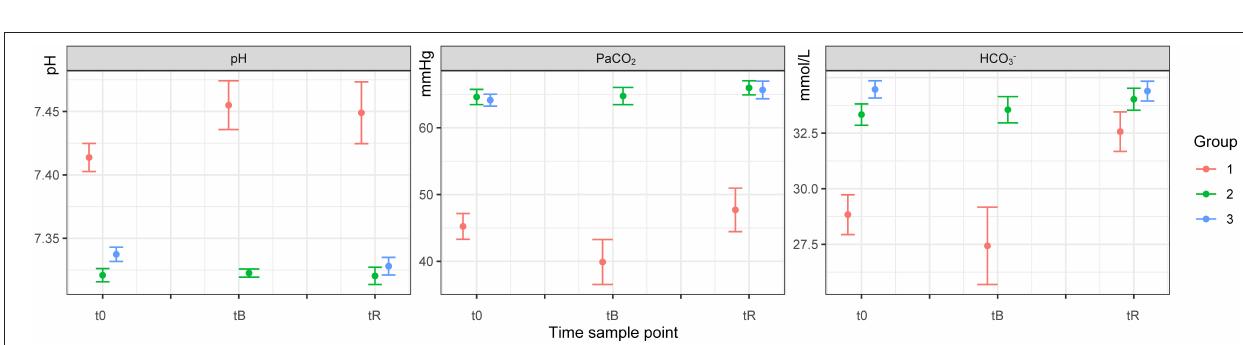
FIGURE 2 | Heart rate, respiratory rate and SpO 2 of white rhinoceroses ( Ceratotherium simum simum ) per group: Group 1, free-ranging ( n = 14), immobilized with ≈ 2.5 µ g/kg etorphine (high dose), ≈ 2.5 µ g/kg medetomidine, ≈ 25 µ g/kg midazolam and 1,500–1,700 IU hyaluronidase; Group 2, game-farmed ( n = 28), immobilized with ≈ 2.5 µ g/kg etorphine (high dose), ≈ 2.5 µ g/kg medetomidine, ≈ 25 µ g/kg midazolam and 1,500–1,700 IU hyaluronidase and Group 3, game-farmed animals ( n = 20) ≈ 1 µ g/kg etorphine (low dose), ≈ 5 µ g/kg medetomidine and ≈ 25 µ g/kg midazolam. Time sampling points: five to 35min after recumbency in 5-min intervals. Data presented as Median